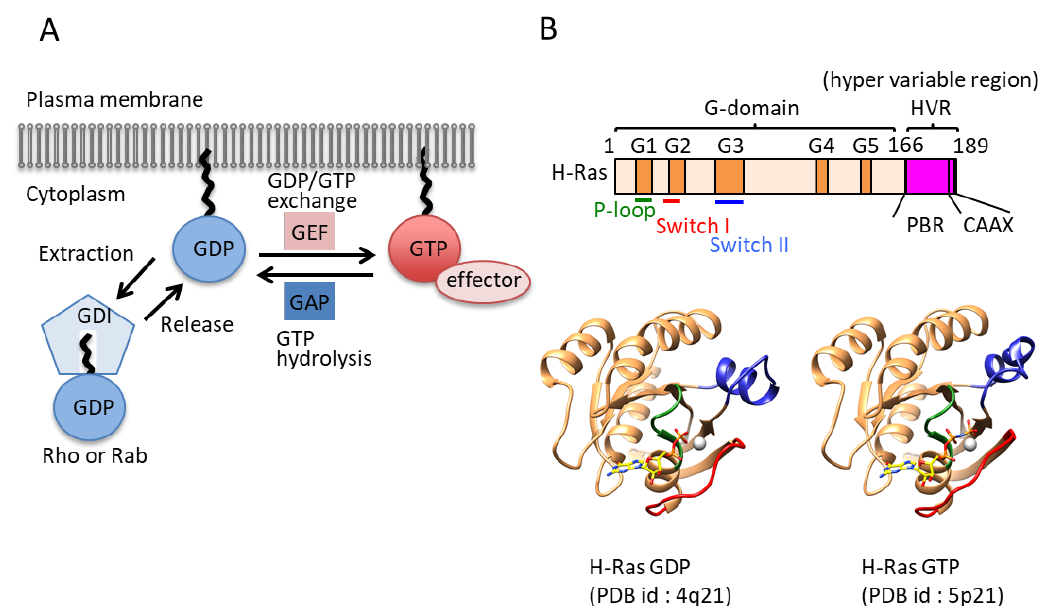
Figure 1. Regulation mechanism of small GTPases: ( A ) Schematic diagram of the small GTPase switching mechanism. Guanine-nucleotide exchange factors (GEFs) and GTPase-activating proteins (GAPs) enhance the exchange reaction. The guanine dissociation inhibitor (GDI) and e ff ector are also shown. Guanosine triphosphate (GTP)-bound and guanosine diphosphate (GDP)-bound GTPases (lipidated forms) are shown as red and blue circles, respectively. GAP and GEF are shown as red and blue boxes, respectively. Several GTPase families combine their GDP / GTP switch with alternations in cytosolic / membrane localization in a process regulated by GDIs or GDI-like proteins. ( B ) General structural information of small GTPases. Upper: The domain architecture of H-Ras. G boxes of the G domain are highlighted with orange boxes. The hyper variable region, including a polybasic region and a CAAX motif, is highlighted with pink boxes. The P-loop, switch I, and switch II are shown as bars colored green, red, and blue, respectively. Lower: Crystal structures of GDP-bound and GTP-bound H-Ras. The P-loop, switch I, and switch II are colored green, red, and blue, respectively. Another key regulator is guanine dissociation inhibitor (GDI). Some GTPases, including the Ras, Rho, and Rab proteins, are prenylated at their C-termini, and their C-terminal regions are